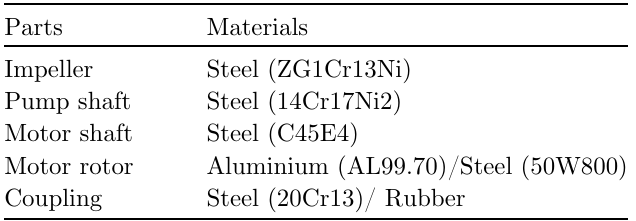
Fig. 11. Finite element model of the shaft (Magenta: the rotor and shaft of the motor; purple: impeller and shaft of the pump; green: the rubber ring for a coupling; blue: the pin of the coupling).